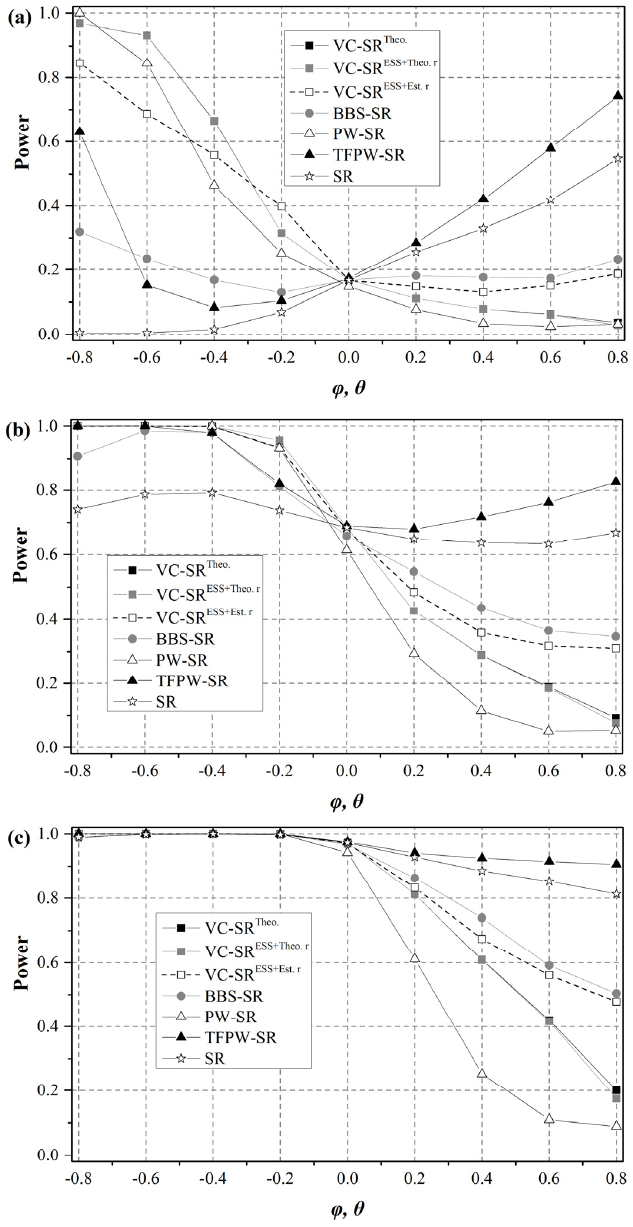
Figure 7. Comparison of the power of different SR tests for ARMA(1,1) series ( n = 50): ( a ) β = 0.002; ( b ) β = 0.005; ( c ) β = 0.008.